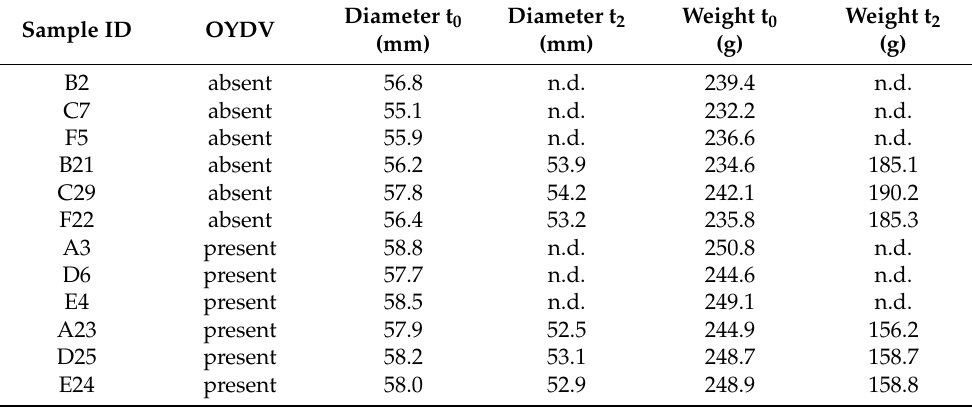
Table 1. Morphological features and weight of sample onion bulbs used for analyses. Sample IDs are coded with a progressive serial number identifying the individual and a letter corresponding to the belonging randomized block (B, C, F healthy; A, D, E infected); n.d. = not determined (sample collected at t 0